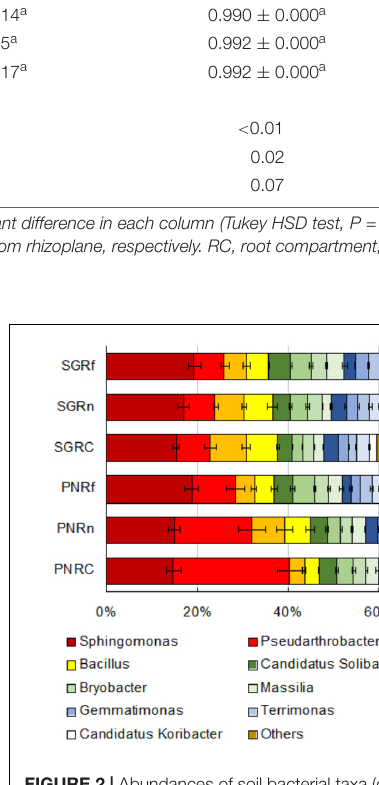
FIGURE 2 | Abundances of soil bacterial taxa (genera with abundance > 1%) as affected by plant species and distance. PN, bahiagrass ( Paspalum natatum ); SG, stylo ( Stylosanthes guianensis ). RC, Rn, and Rf indicate root compartment, the near (0–5 mm) and the far (10–15 mm)